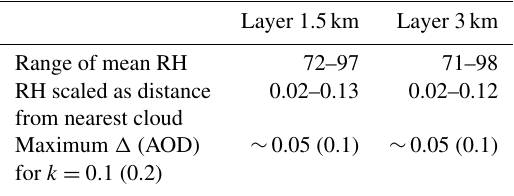
Table 3. Estimating change in AOD ( (cid:49) AOD) due to variation in RH. The hygroscopicity parameter, k used in the estimation was taken as 0.1 and 0.2 to illustrate minimum and maximum change due to change in aerosol properties.